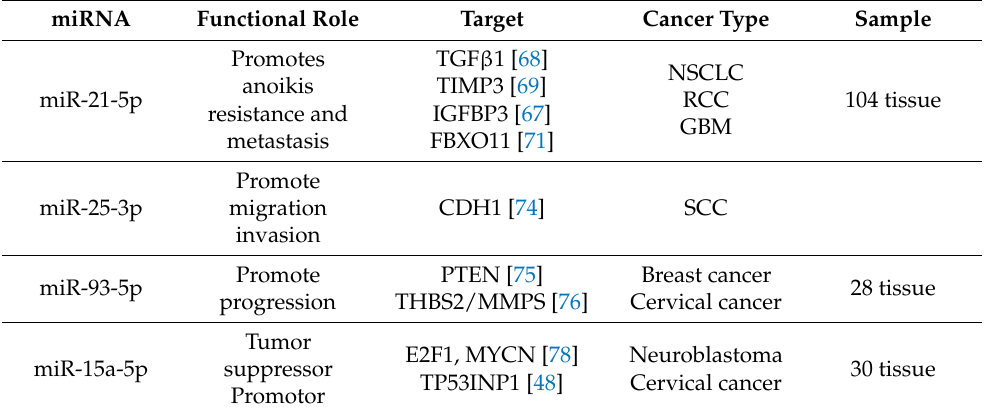
Table 4. Functional roles and validated targets of miRNAs associated with EAC diagnosis.